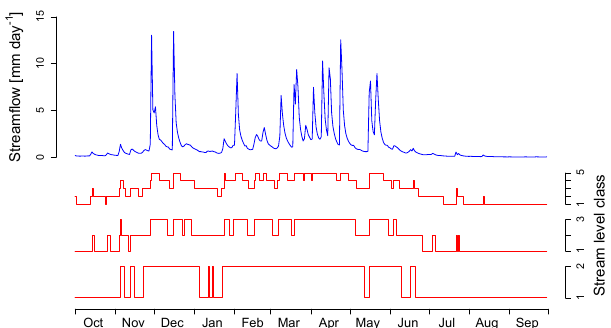
Figure 1. Time series of the observed streamflow (blue) for the first year of simulation (October 1982–September 1983) for catchment 002011460 (Back Creek near Sunrise, VA), a medium sized catch- ment (235km 2 ) with a medium aridity index (1.33), and the derived time series of the stream level class for the case of two, three and five level classes (red), where the stream level is in each water level class for, respectively, 50, 33 and 20% of the